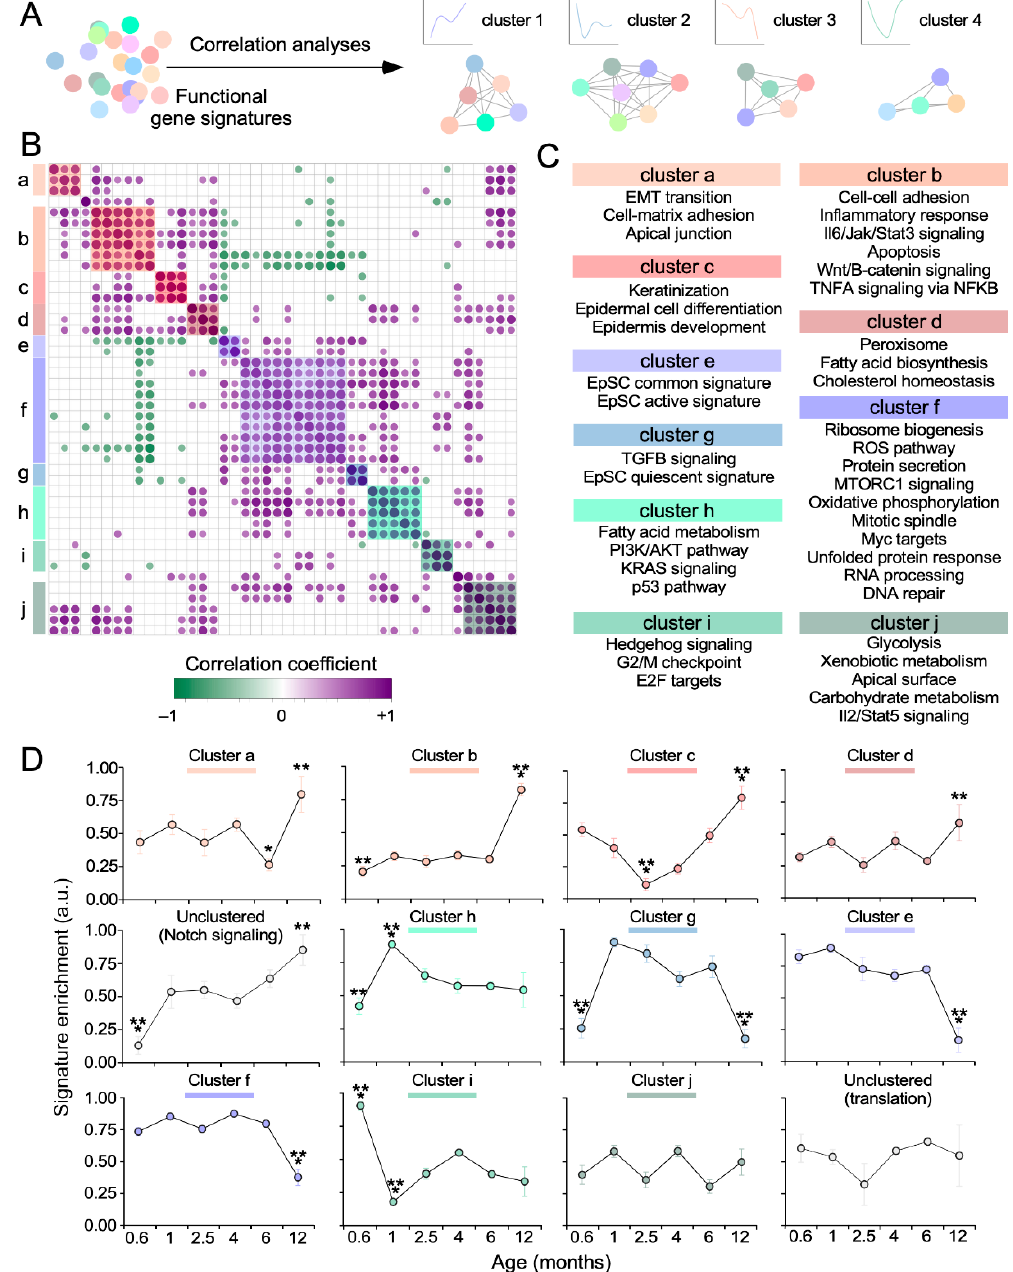
Figure 3. Key SSC-linked signaling pathways are age-sensitive. ( A ) Scheme representing how highly coexpressed pathways are assigned to specific coexpression clusters. Correlation matrix ( B ) and functional clusters ( C ) obtained with the in silico strategy indicated in (A). Only correlations with p values below the significance threshold of 0.05 were considered. Positive and negative correlations are shown in purple and green, respectively. Dot size and color reflects the magnitude of the Pearson correlation coefficient ( r ). Coexpression clusters are shaded in color (B,C). ( D ) Plots showing the enrichment pattern across time of the different pathway clusters identified in panel B. *, p < 0.05; **, p < 0.01; ***, p < 0.001 (Mann–Whitney test). Data represent the mean ± SEM.